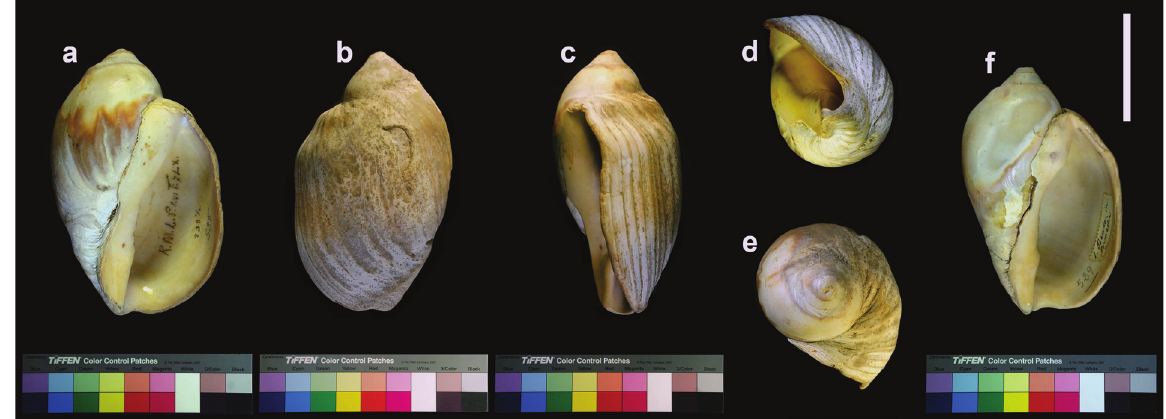
Figure 46. Voluta oviformis fratercula . a–e Specimen figured by Lahille (1895: pl. X, fig. 7) a Apertural view b Dorsal view c Lateral view d Umbilical view e Apical view f Specimen figured by Lahille (1895: pl. X, fig. 8) in apertural view. Scale bar: 5